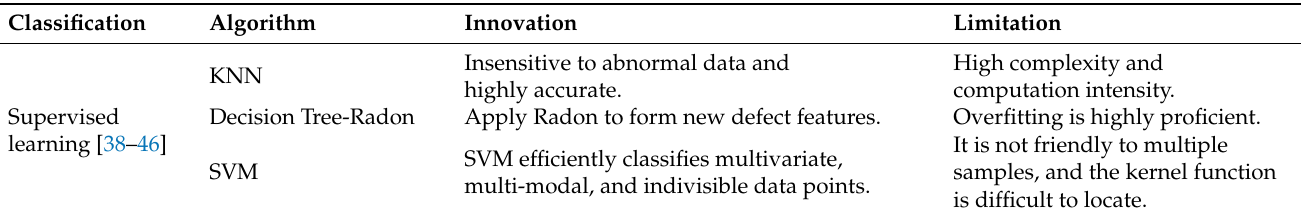
Table 2. Comparison on machine learning